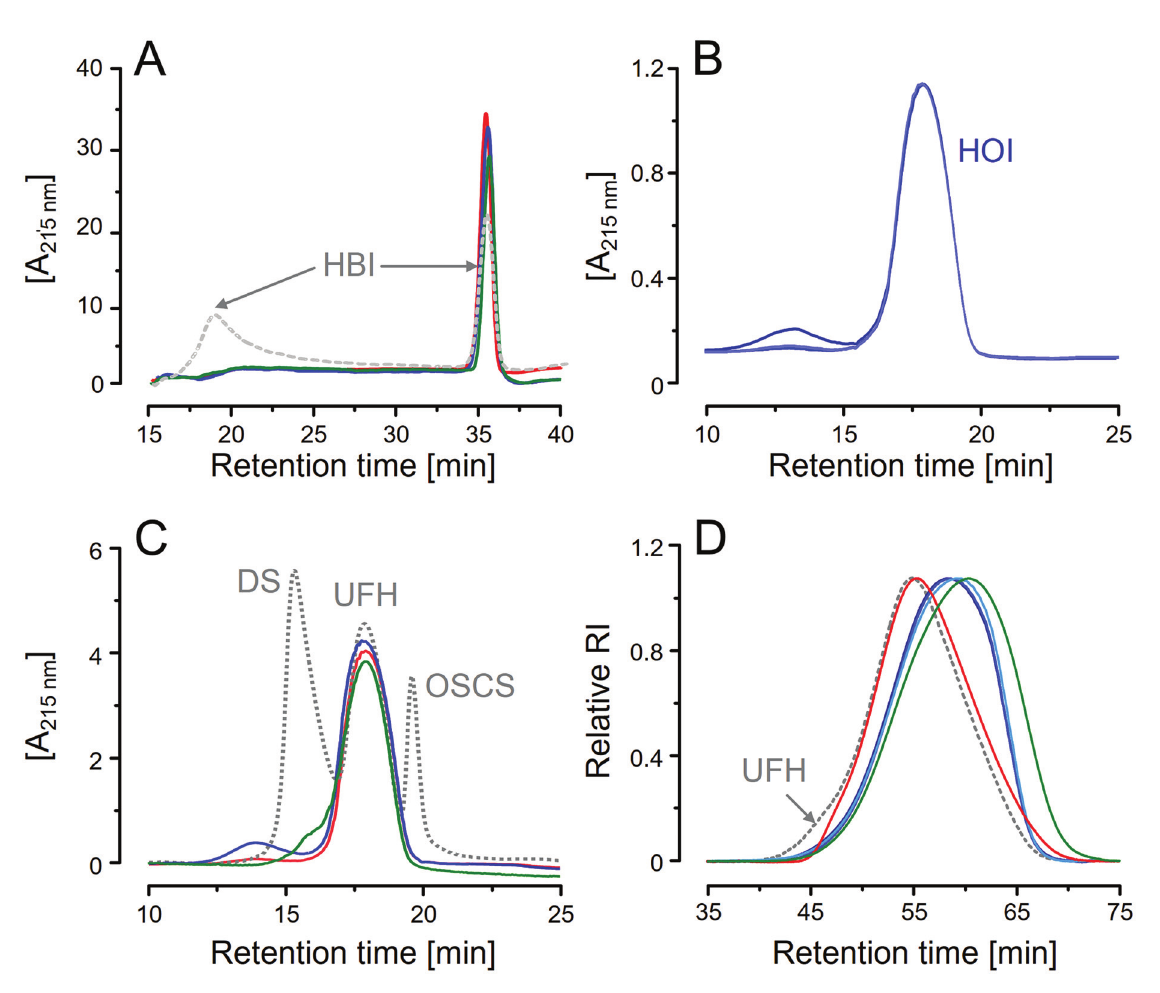
Fig. 2 Chromatographic analysis. (A) Hi-resolution anion-exchange chromatograms show that HOI, HBL and HPI are composed by single populations of heparin chains (solid lines in blue, green and red, in all panels) whereas HBI is an heterogenous mixture of two heparin types (dashed gray line). Analytical anion-exchange chromatograms of three batches of HOI (B) and of one batch of each HOI, HBL and HPI and a mixture containing dermatan sulfate (DS), 6 th International Heparin Standard (HPI) and oversulfated chondroitin sulfate (OSCS; all depicted as a continuous dotted gray line). (D) Analytical size-exclusion chromatograms of HOI (3 batches), HBL, HPI and USP heparin molecular-weight calibrant (UFH; dotted gray